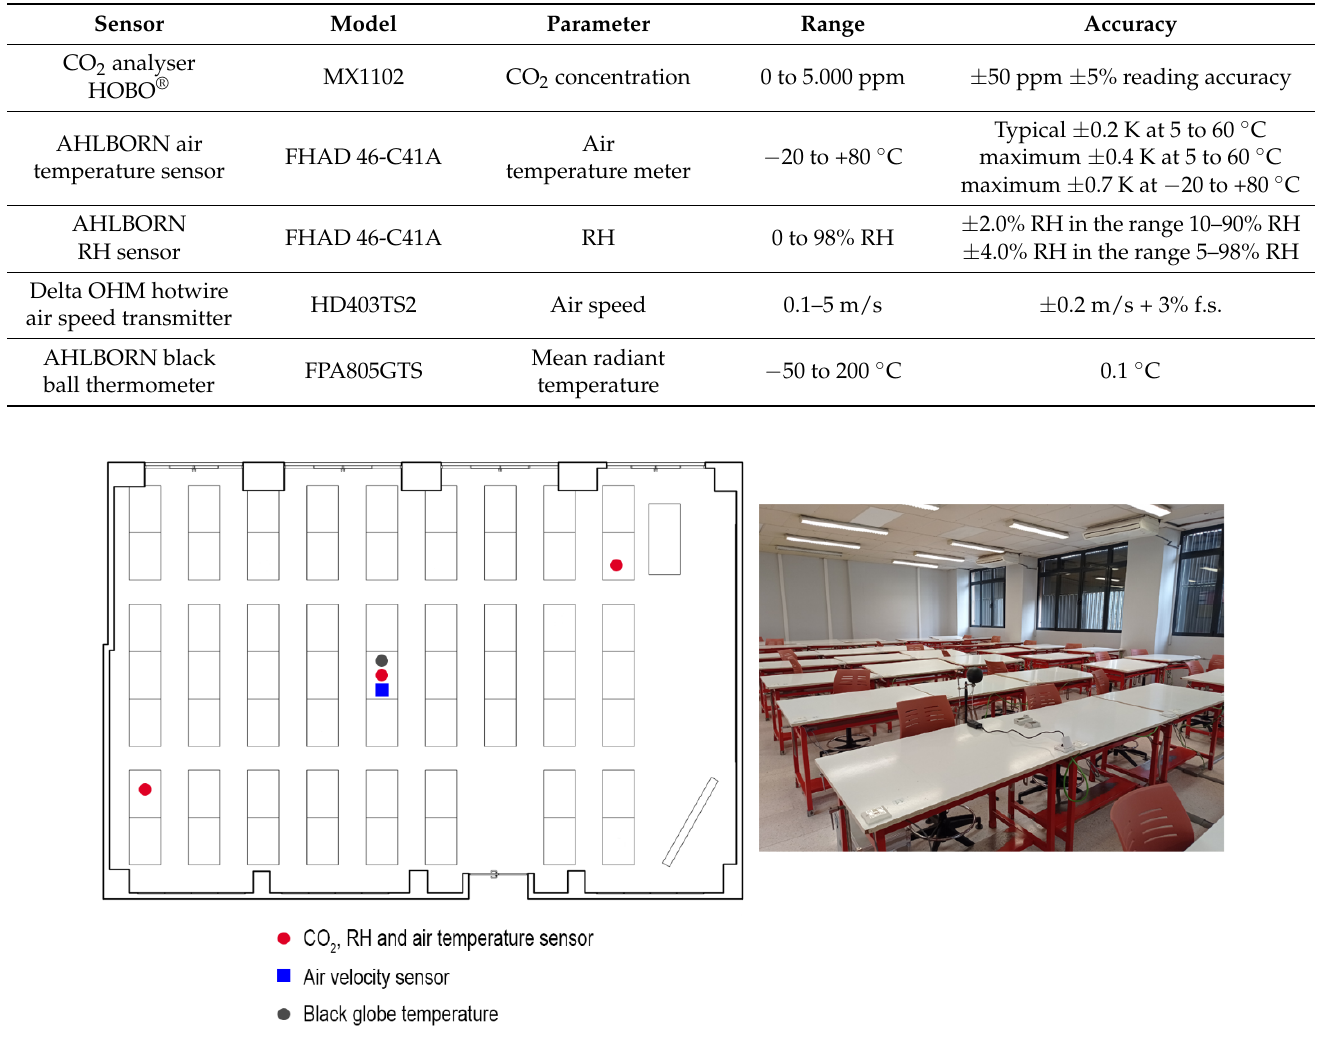
Figure 3. Example of the layout of the sensor locations during field measurements.